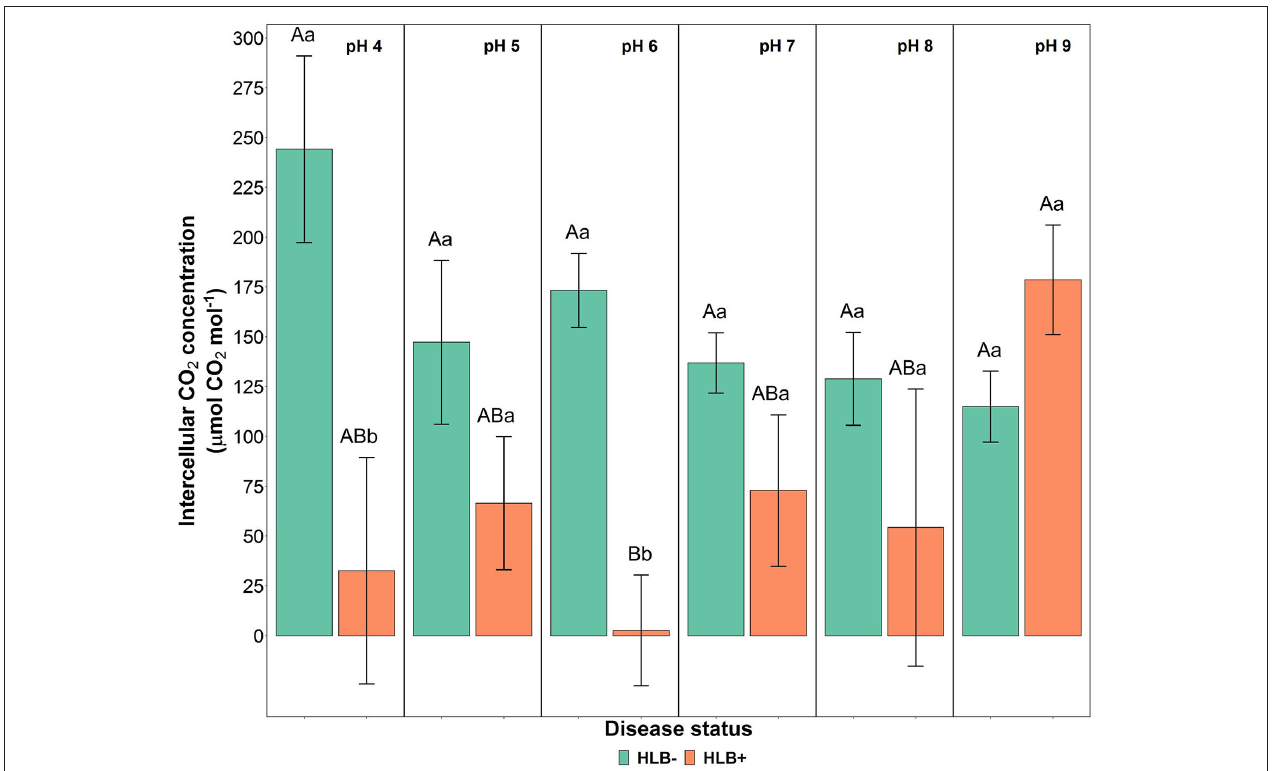
FIGURE 5 | Leaf intercellular CO 2 concentration interaction of “Ray Ruby” grapefruit ( C. paradisi ) on sour orange ( C. aurantium ) rootstock exposed to different HLB disease statuses [HLB-free or healthy (negative, HLB–) and HLB-affected (positive, HLB + )] under an increasing range of substrate pHs (4–9). Means ± standard error ( n = 4) followed by the same letters are not different by Tukey honest significant difference (HSD, α = 0.05). Means with the same uppercase letters are not different on each substrate pH within disease status, and means with the same lowercase letters are not different within the disease status per substrate pH.